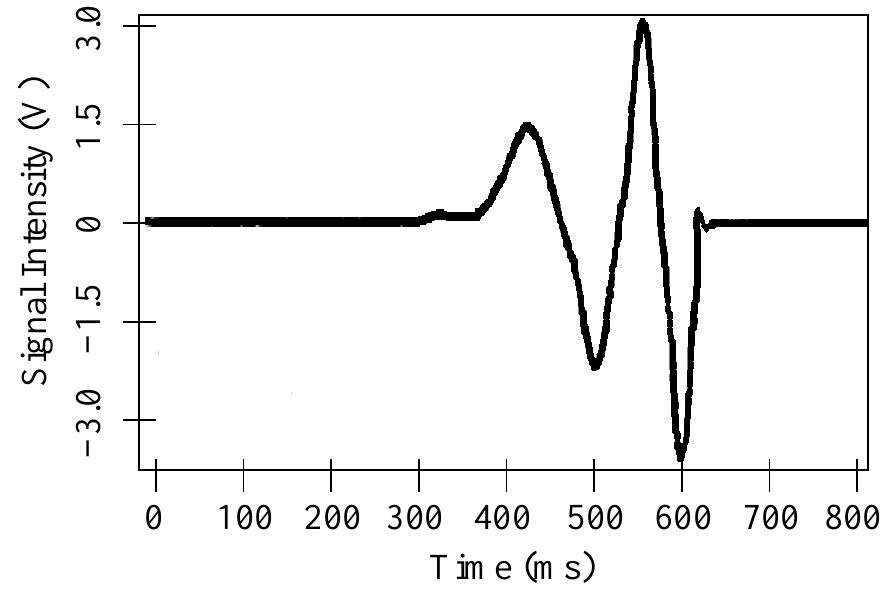
Figure 3. Waveform at the output of the magnetic kinetic generator module, after a full